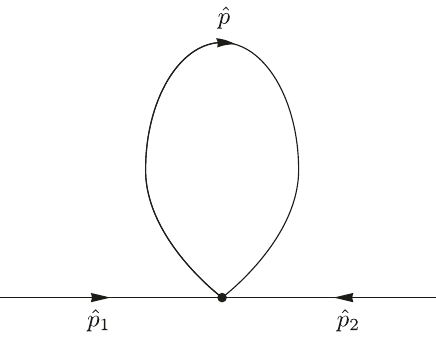
Figure 6 . One-loop correction to the propagator.